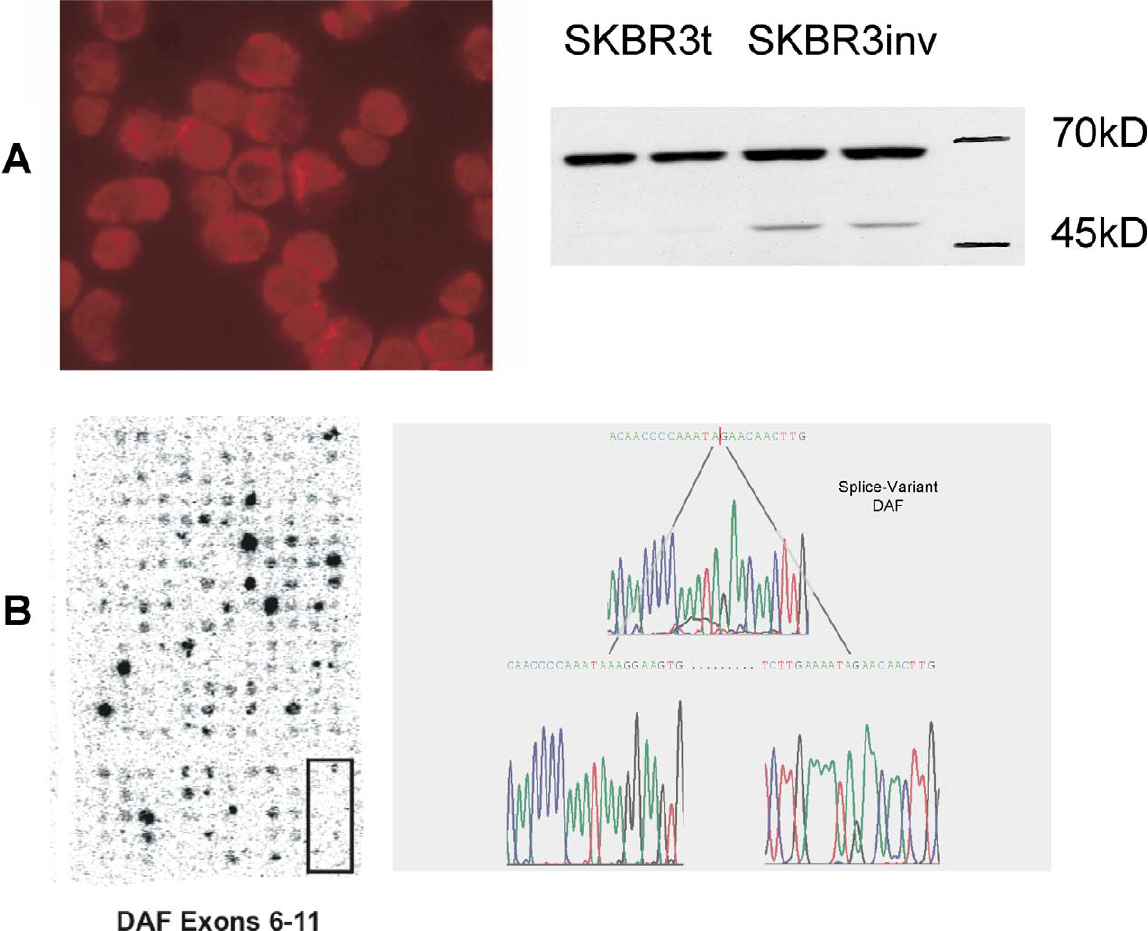
Fig. 2. (A) Immunocytochemical demonstration of the decay-accelerating factor (red fluorescent staining in SK-BR-3 cell line (left). Western blot analysis: differential expression of the DAF 45 kDa isoform was reflected by the detection of this protein in the invasive subclone SKBR3inv (right). (B) Radioactive RNA in situ hybridisation (RISH) on freshly frozen tissue microarrays: tissue samples from 230 mammary carcinomas and 10 normal mammary tissues (outlined in a black box, lower right) were analysed for the expression of different DAF splice variants. Tissue samples with strong expression are depicted in black (left). The portion of the abridged DAF c-DNA sequence in which alternative splicing occurs